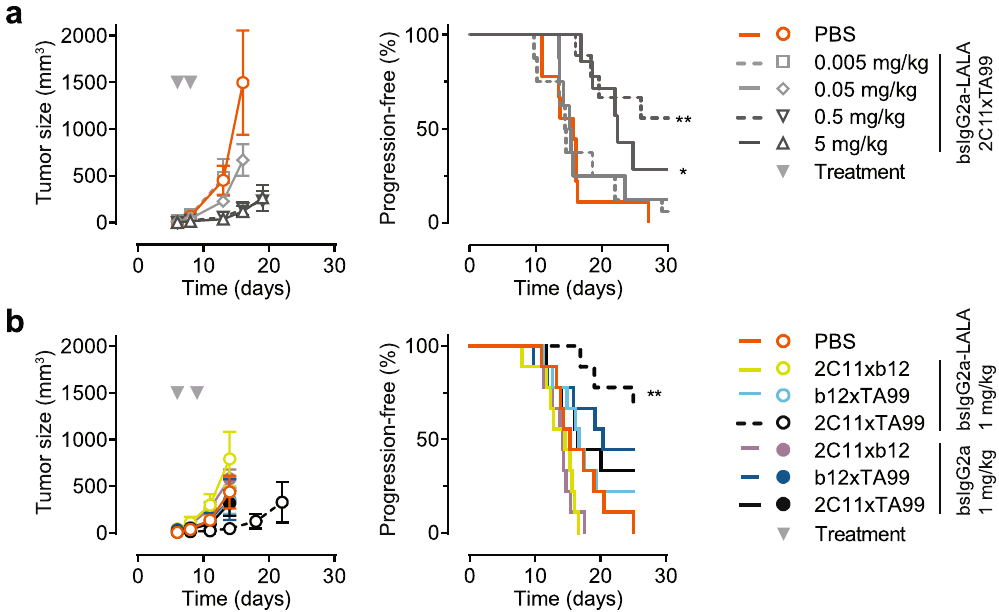
Figure 6. Evaluation of the in vivo efficacy of bsIgG2a-2C11xTA99(-LALA) in a syngeneic xenograft model with gp75-expressing B16-F10 tumor cells. ( a ) On day 6, mice were randomized (n = 7–9 per group) and treated intravenously with the indicated bsIgG2a-2C11xTA99-LALA doses, followed by a second dose at day 8 (arrowheads indicate treatment days). ( b ) On day 6, mice were randomized (n = 9 per group) and treated intravenously with the indicated bsAb variants at 1 mg/kg, followed by a second dose at day 9 (arrowheads indicate treatment days). Left panels show mean tumor volumes ± SEM (at time points where groups were still complete). Right panels show percentage of mice that remain progression-free (as defined by a tumor volume below 500 mm 3 ). Statistical significance was determined by Mantel-Cox analysis ( * P < 0.05; ** P <